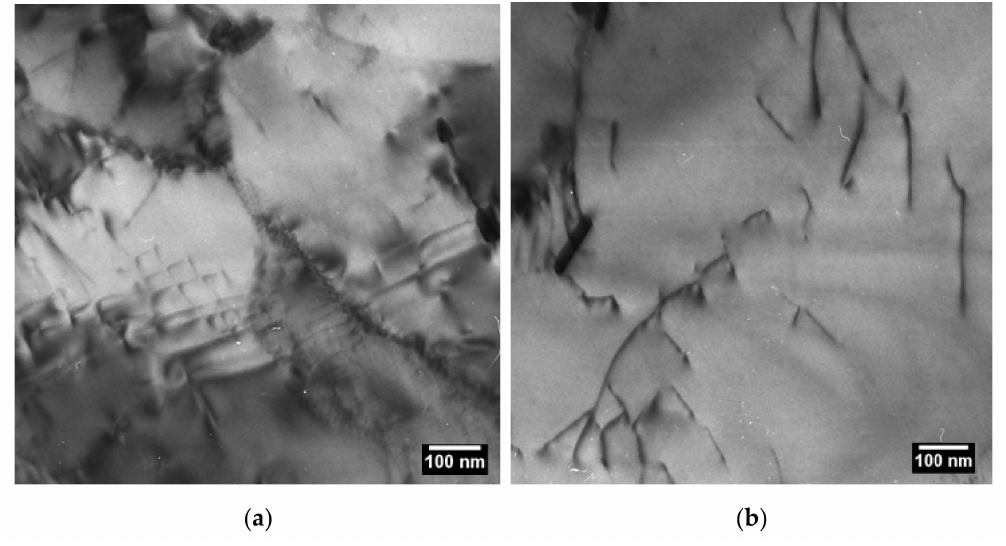
Figure 5. ( a ) Subgrain boundaries and ( b ) internal dislocations in condition 2 (1000 h, 700 ◦